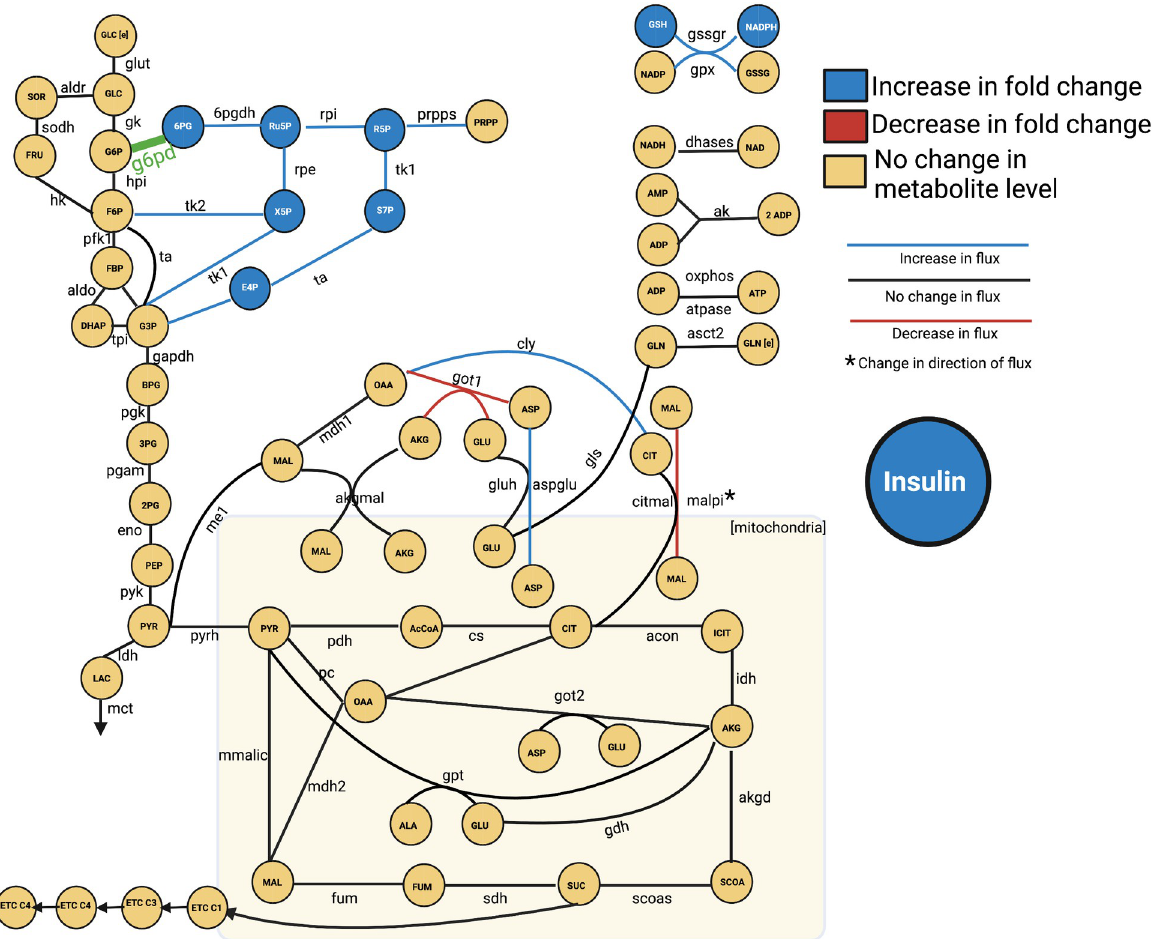
Fig 9. Effect of agrimony treatment. We implemented agrimony as a 5-fold increase in the g6pd reaction, and assessed the effect on the network, comparing metabolite levels, reaction fluxes, and insulin secretion to the unperturbed condition.